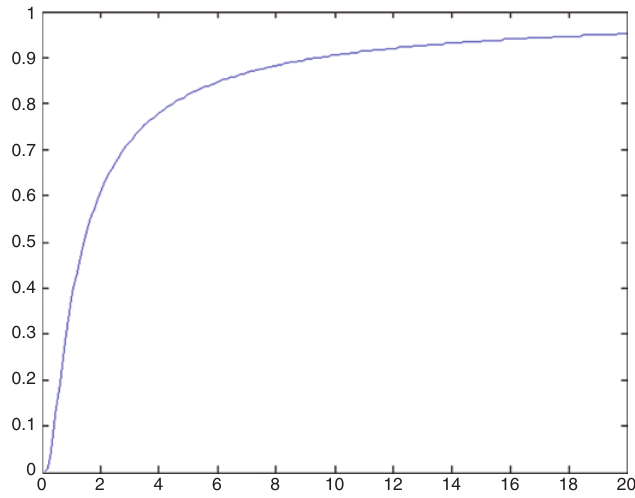
Figure 1. y = exp(–1/ x